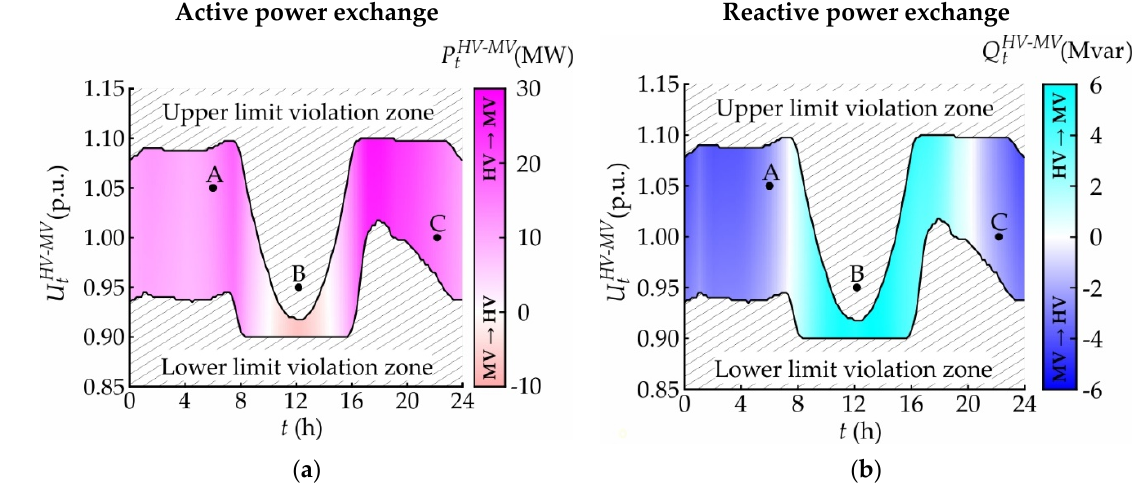
Figure 12. Daily behavior of the MV grid for various voltages at the HV–MV boundary node: ( a ) HV–MV active power exchange; ( b ) HV–MV reactive power exchange.